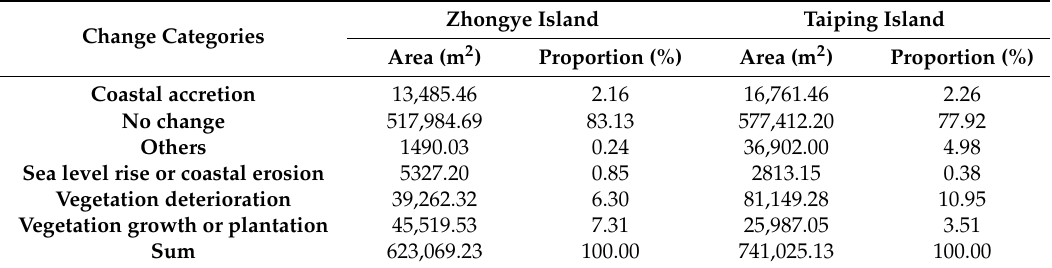
Table A3. The area and proportion of all change categories in Barque Canada Reef. Change Categories